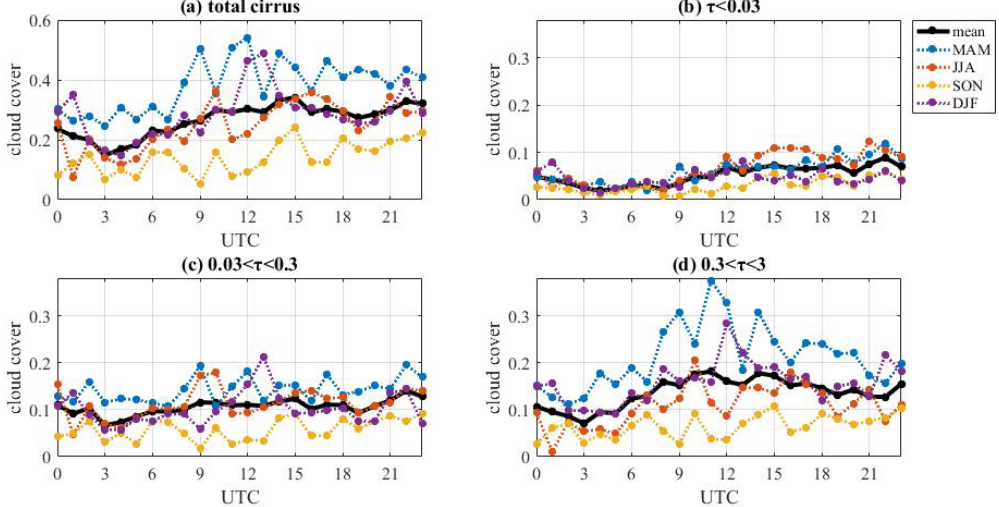
Figure 6. The hourly cloud cover of different types of cirrus of different seasons. The black lines represent the results of annual average, the blue lines represent the results of spring, the red lines represent the results of summer, the yellow lines represent the results of autumn, the purple lines represent the results of winter. All seasons here are northern hemisphere seasons. (a) represents the cloud cover of all cirrus. (b) represents the subvisible cirrus (optical thickness less than 0.03). (c) represents the thin cirrus (optical thickness between 0.03 and 0.3). (d) represents the opaque cirrus (optical thickness between 0.3 and 3).